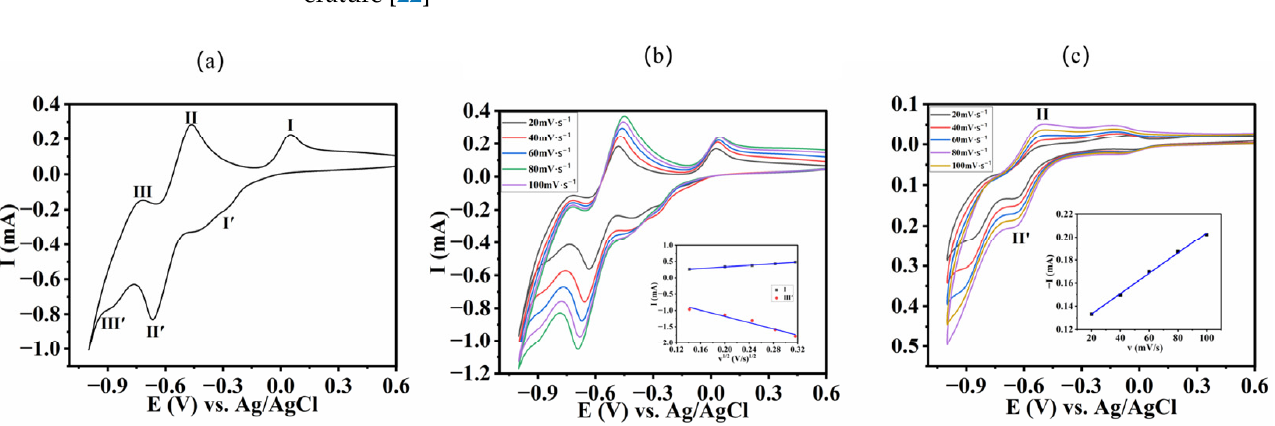
Figure 2. CV curve of bare ITO in 1.0 mM Cu 4 P 4 W 30 solution in 0.5 M HAc + 0.5 M NaAc at pH 5 with scan rate of 50 mV·s − 1 ( a ); CV curves of Cu 4 P 4 W 30 in solution in 0.5 M HAc + 0.5 M NaAc (pH 5) at di ff erent scan rates from 20 to 100 mV·s − 1 ; the inset shows the linear relationship between peak currents (II and II’) and square root of scan rates ( b ); CV curves of the ITO/(Cu 4 P 4 W 30 /PDDA-GO) 1 electrode in 0.5 M HAc + 0.5 M NaAc (pH = 5) at di ff erent scan rates from 20 to 100 mV·s − 1 ; the inset shows the linear relationship between the peak currents (II’) and scan rates ( c ).